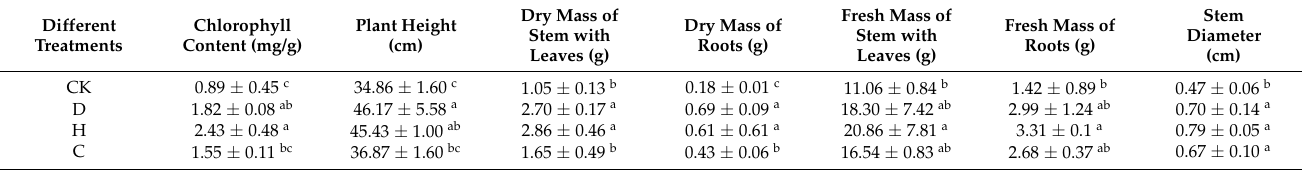
Table 2. Chlorophyll content and physiological parameters in different treatment groups of Faba